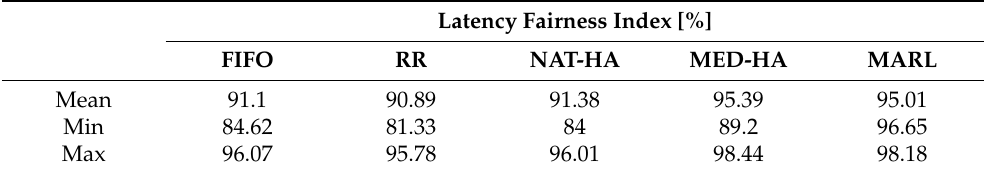
Table 10. Latency fairness in topology 4 with random flow.